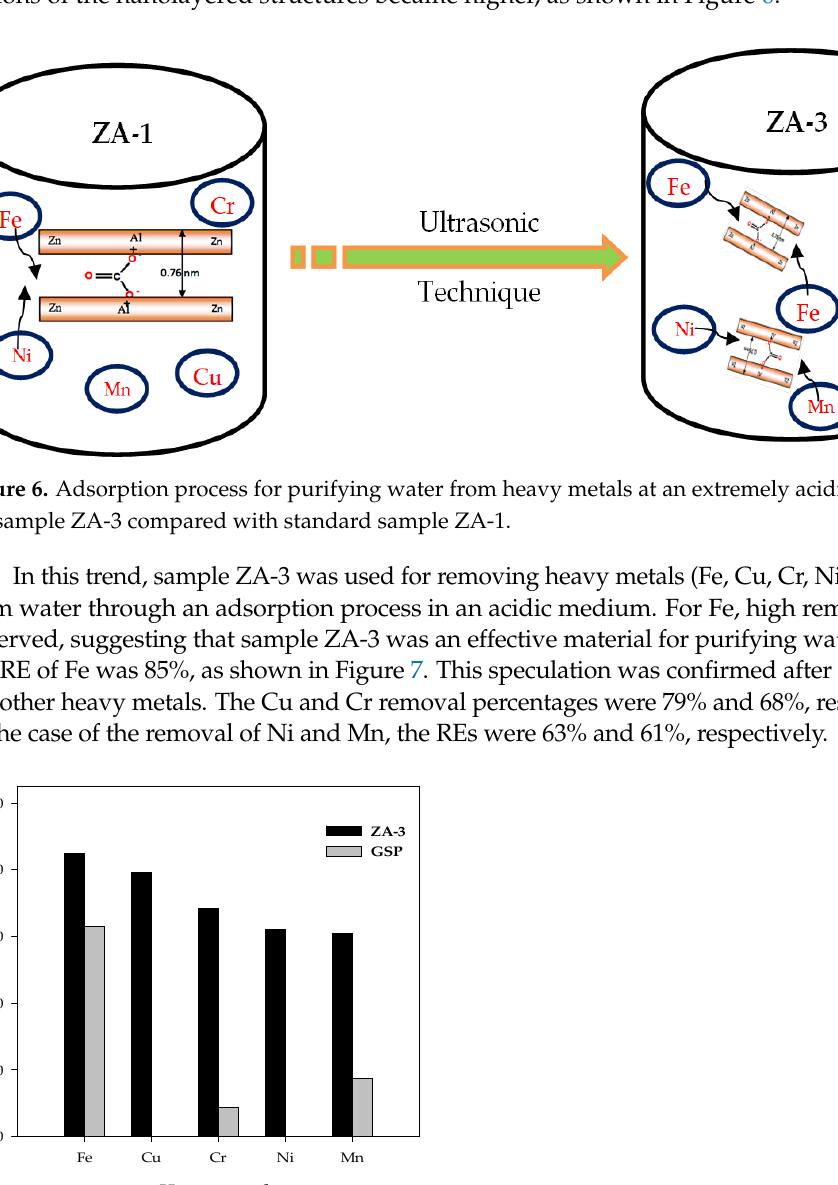
Figure 5. Sample ZA ‐ 3: ( a ) TEM images (inset: EDX spectrum) and ( b ) TEM images in another lo ‐ cation.